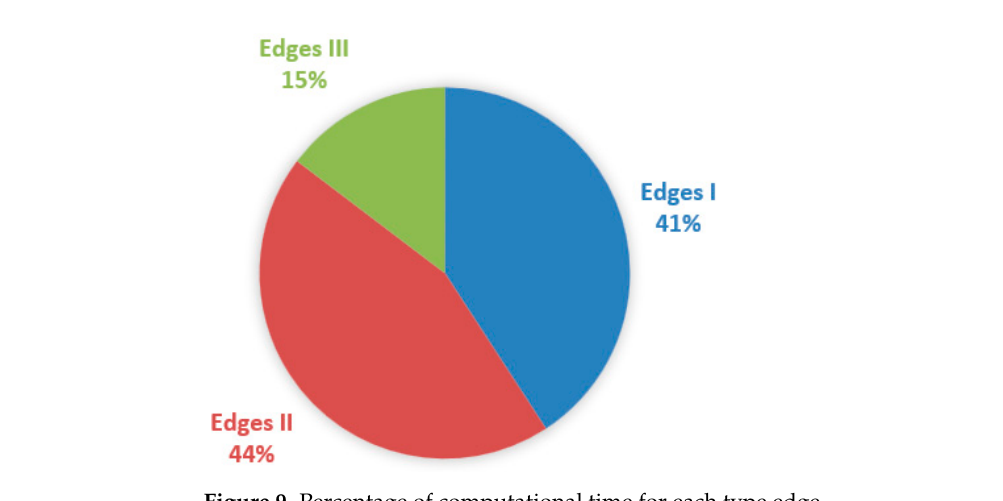
Figure 9. Percentage of computational time for each type edge.